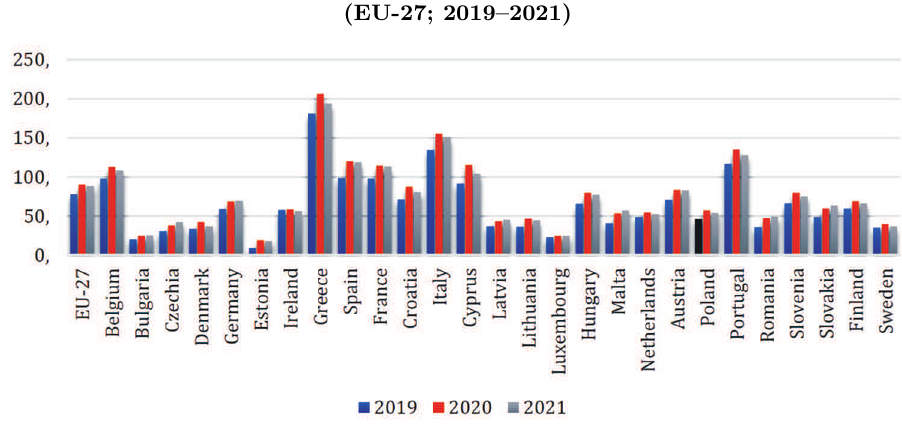
General government debt as a percentage of GDP (EU-27;